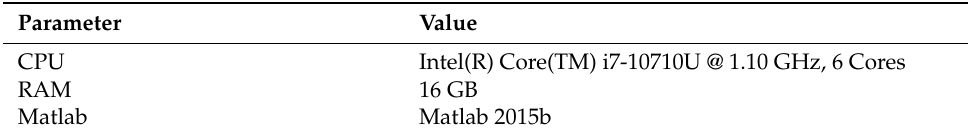
Table 1. Experimental configuration.